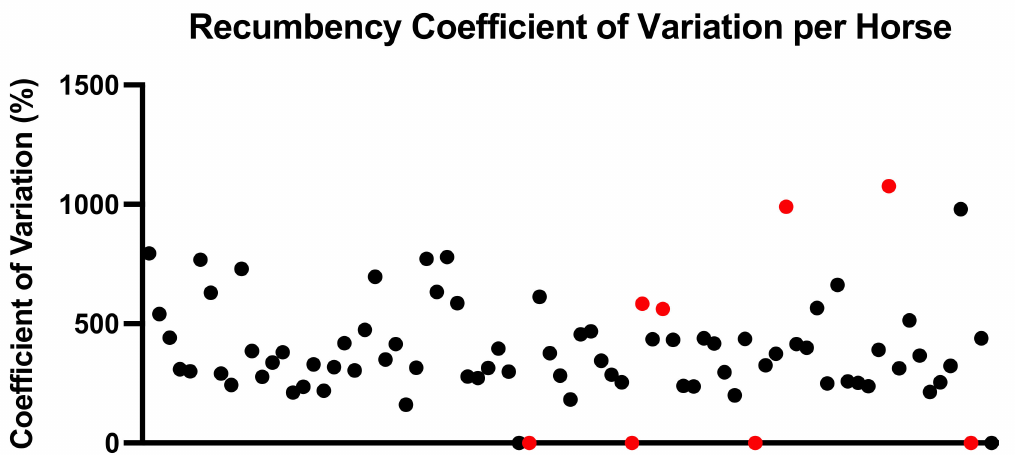
Figure 5. Coefficient of Variation (%) of recumbency times. Horses (distributed alphabetically along the x-axis) with established REM deficiency symptoms are indicated in